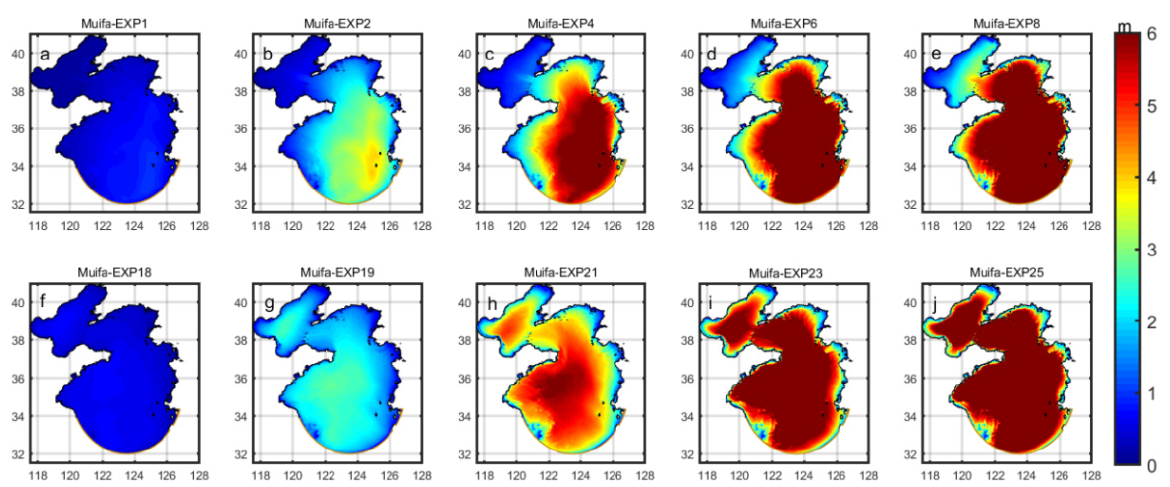
Figure 7. Spatial distribution of a significant wave height when the maximum wind speed was ( a ) 10 m/s, ( b ) 20 m/s, ( c ) 30 m/s, ( d ) 40 m/s, and ( e ) 50 m/s based on Typhoon Muifa and ( f ) 10 m/s, ( g ) 20 m/s, ( h ) 30 m/s, ( i ) 40 m/s, and ( j ) 50 m/s based on Typhoon Lekima.